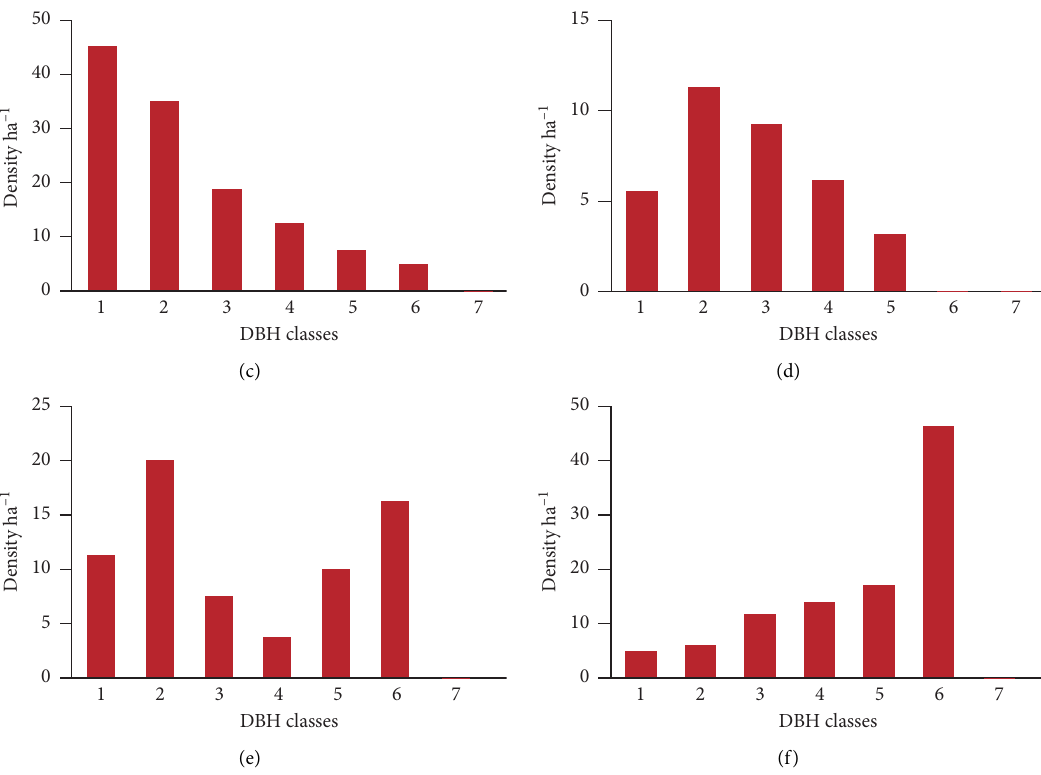
Figure 9: Pattern of frequency distribution of selected tree species over DBH classes (1 � 5–10 cm; 2 � 10.01–20cm; 3 � 20.01–30 cm; 4 � > 30.01–40cm; 5 � 40.01–50cm; 6 � 50.01–80cm; 7 � > 80cm) in all sites. (a) C. zenkeri in site I. (b) P. altissima in site II. (c) B. unijugata in site III. (d) B. abyssinica in site I. (e) V. auriculifera in site I. (f) A. abyssinicus in site